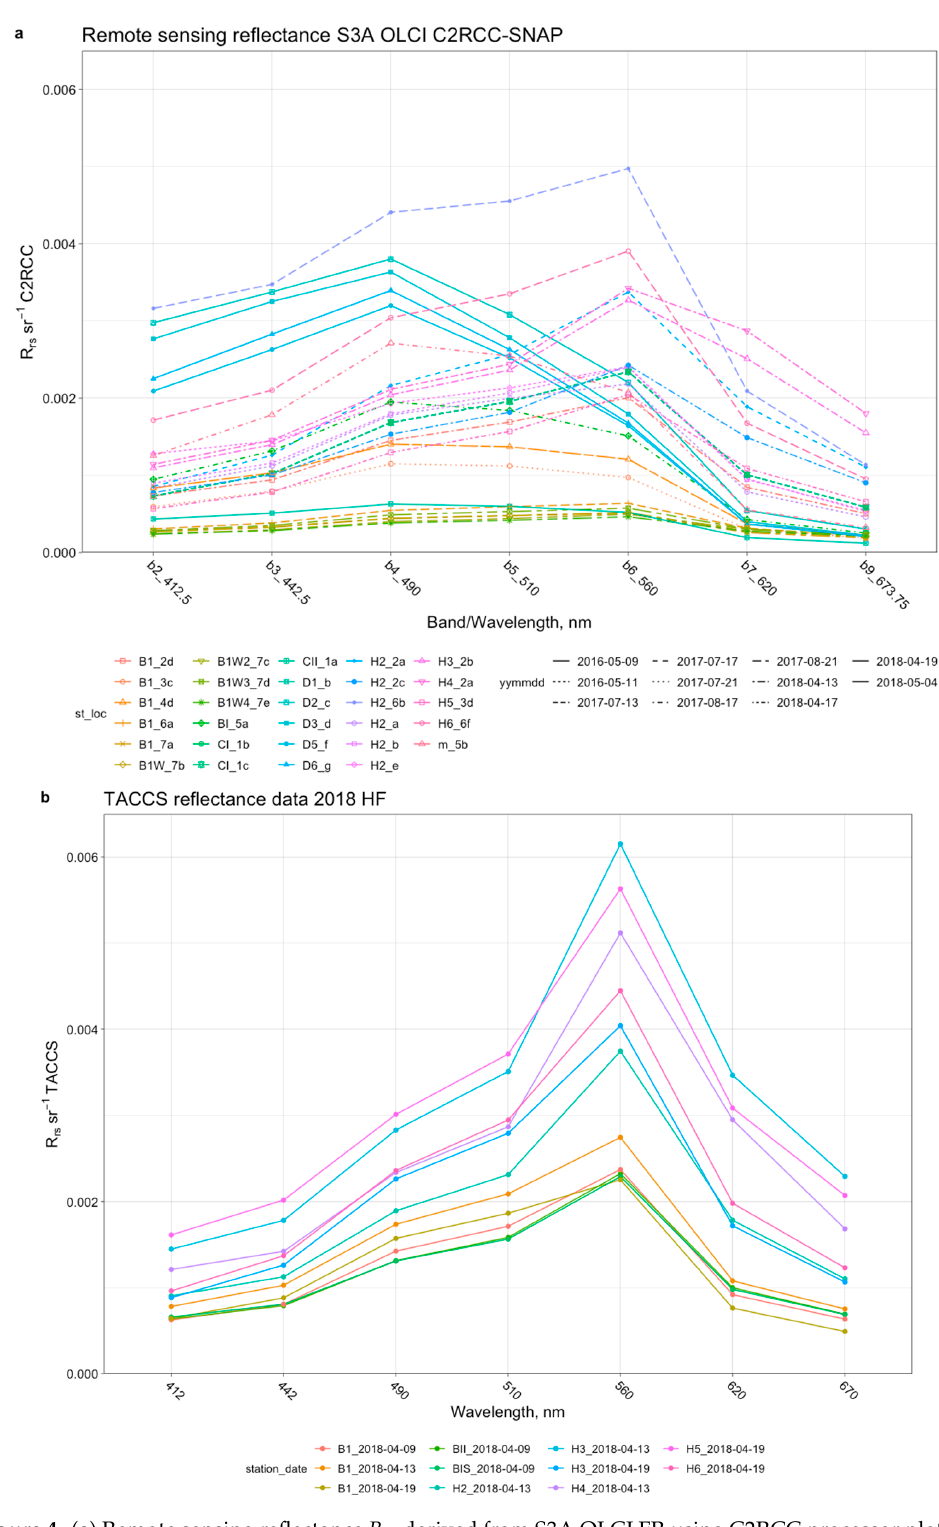
Figure 4. ( a ) Remote sensing reflectance R rs derived from S3A OLCI FR using C2RCC processor plotted in the 400–673 nm range for all sampling stations from all three validation campaign seasons in HF, 2016–2018; ( b ). Remote sensing reflectance, Rrs , derived from the TACCS processor during the field campaigns in the Baltic proper 2018. H and B stations denote stations in the Baltic proper. The in situ reflectance data does not indicate the observed shift towards 490 nm as indicated by the satellite